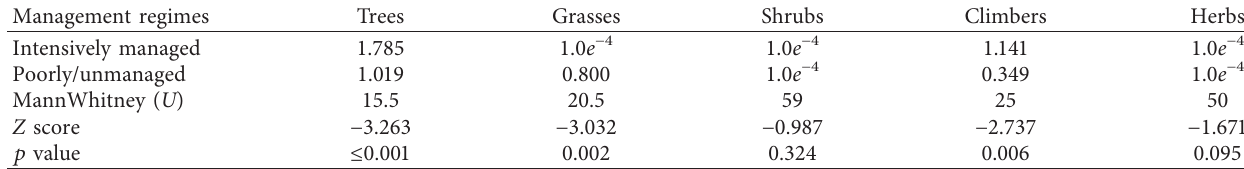
Table 5: Understorey floristic diversity of life forms in the intensively and poorly managed Tectona grandis plantation. Management regimes